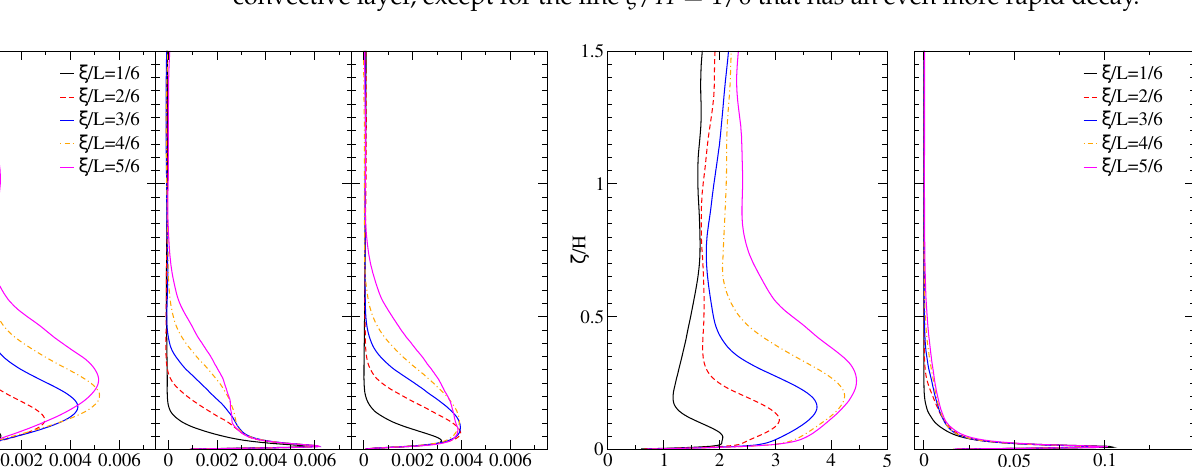
T (cid:48) (cid:105) , slope-normal turbulent heat flux (cid:104) u (cid:48) ξ